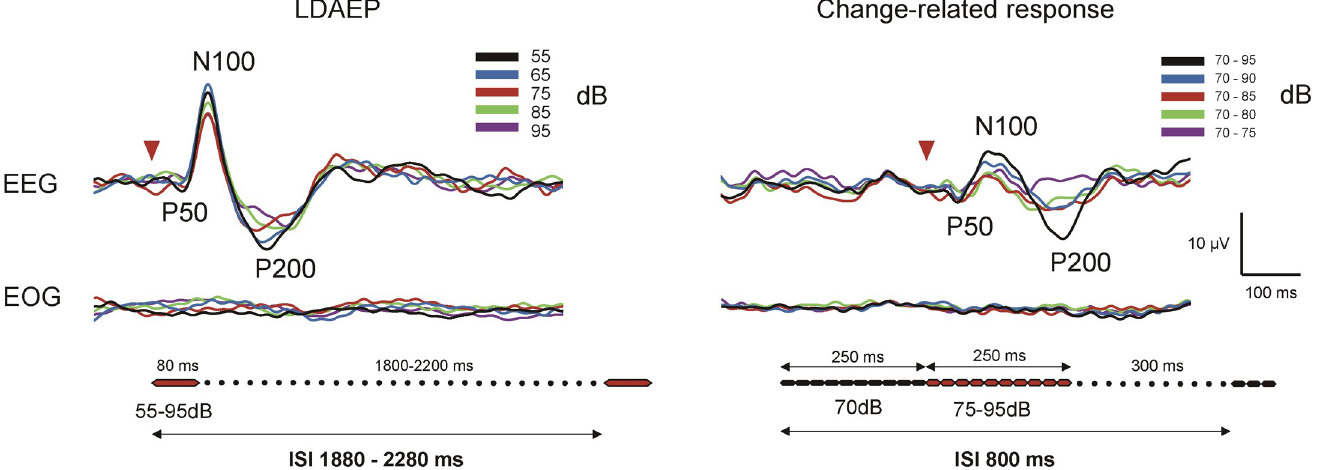
Fig 1. Waveforms of a representative subject. Both the onset and abrupt sound pressure increase evoked a triphasic response with peaks at approximately 50 (P50), 100 (N100), and 200 (P200) ms, with peak amplitudes measured in the time windows of 30–80, 80–150, and 150–280 ms, respectively. The EOG does not affect evoked potentials for either LDAEP or change-related responses. LDAEP, loudness-dependent auditory evoked potentials; ISI, interstimulus interval.